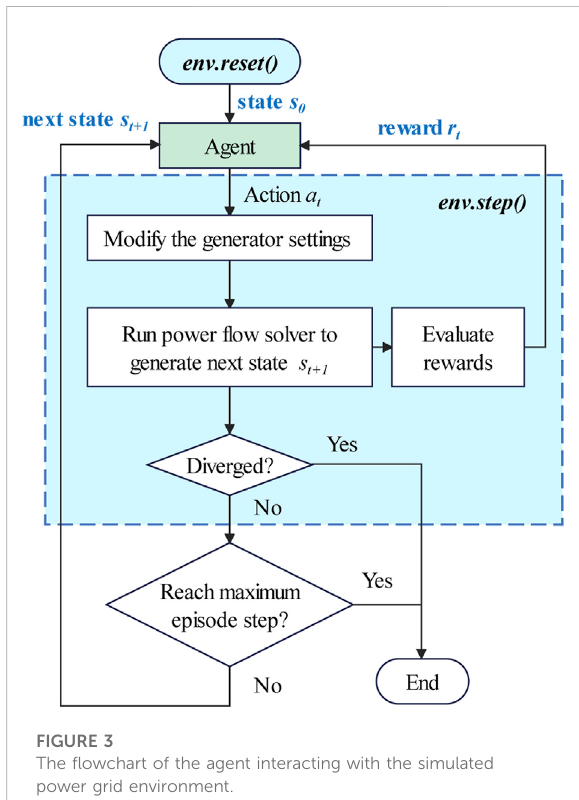
FIGURE 3 The fl owchart of the agent interacting with the simulated power grid